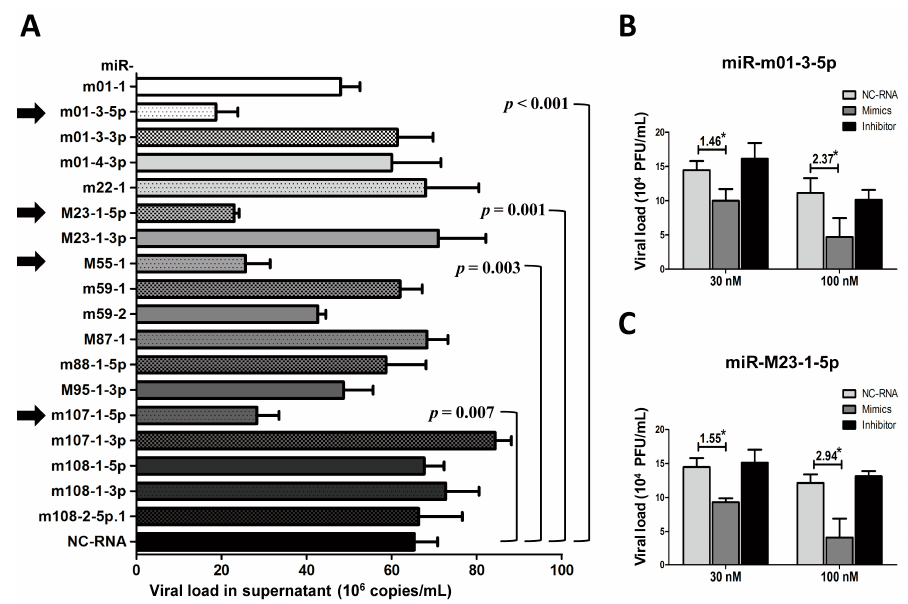
Figure 4. The overexpression of several Group 2 viral miRNAs inhibits MCMV replication. MEF cells were transfected with specific mimics of viral miRNAs or NC-RNA, followed by MCMV infection. Viral copies were quantified at 72 hpi using qPCR ( A ). To further investigate the effects of viral miRNAs on MCMV replication, the mimics, inhibitors of two representative miRNAs (miR-m01-3-5p and miR-M23-1-5p), or NC-RNA were transfected into MEFs at two concentrations (30 and 100 nM), followed by MCMV infection. Viral titers were examined using TCID 50 assays, as described above ( B , C ). The results are shown as the mean ± SD. The assays were performed in triplicate wells, and all data were confirmed with three independent experiments. The different fold changes are shown above the horizontal bar. * p < 0.05 for viral miRNA-transfected versus NC-RNA-treated